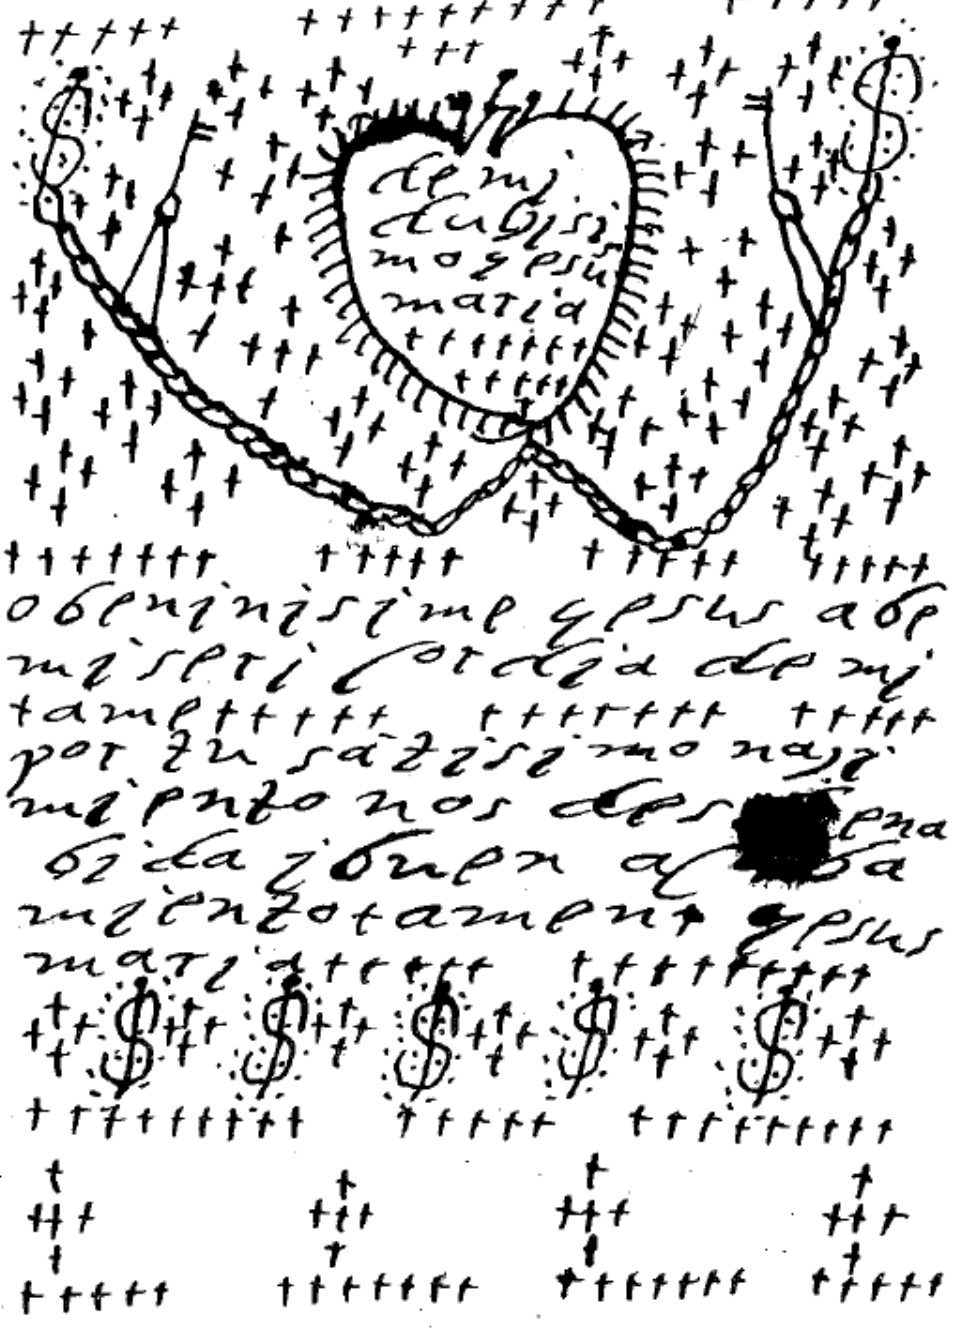
Figure 1. Signature with crosses.